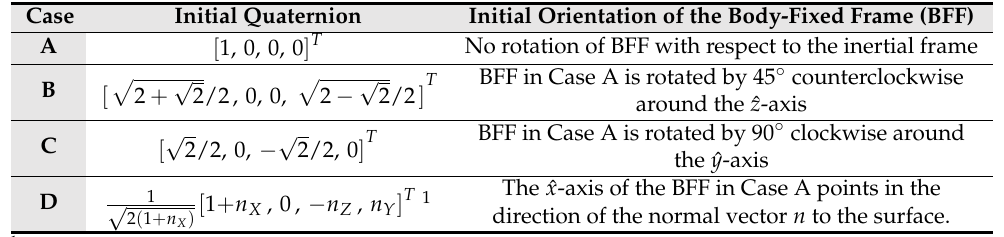
Table 1. Initial quaternions at t = 0 for the initial orientations of the shell shown in Cases A–D in Figure